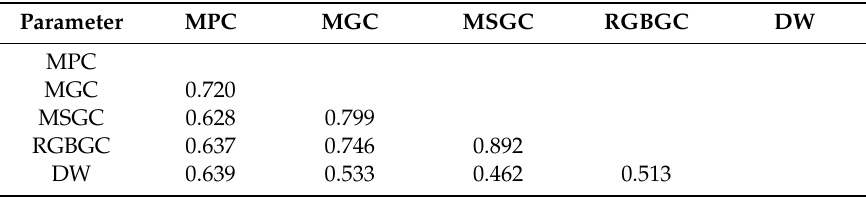
Table 1. The Pearson’s correlation between manual parameters and sensor-based observations. p value < 0.001 for all correlation.